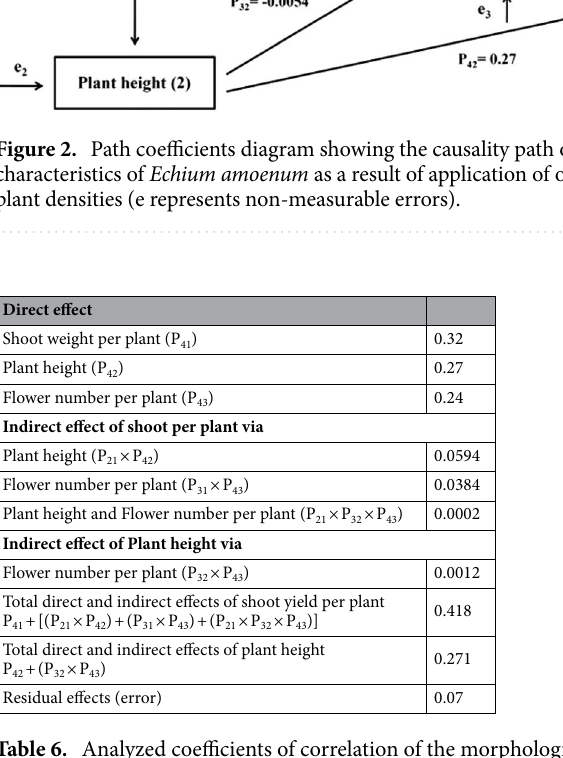
Table 6. Analyzed coefficients of correlation of the morphological characteristics affecting dry flower yield of Echium amoenum to direct and indirect